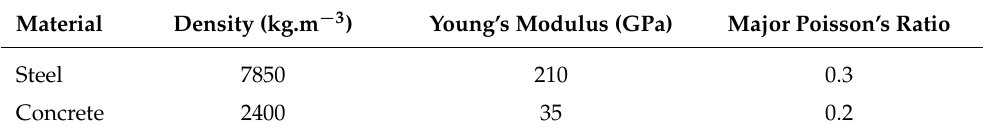
Table 1. Main physical properties of the materials implemented in Ansys ®